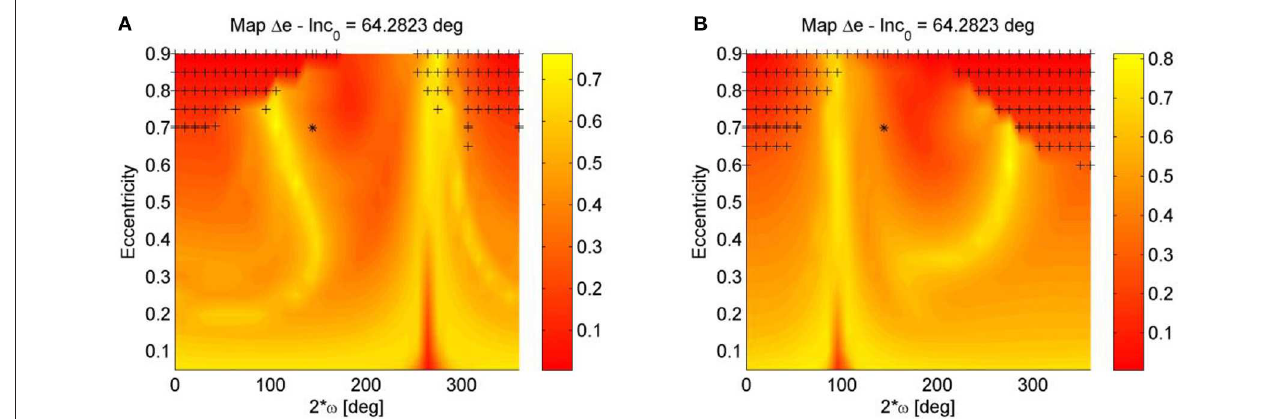
FIGURE 5 | Luni-solar zonal 1 e maps for XMM Newton orbit: (A) Forward propagation, and (B) backward propagation. The initial inclination and the argument of + the perigee are measured with respect to the Moon’s plane.